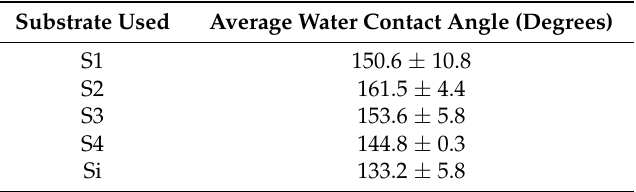
Table 2. Contact angle between a water droplet and the CNT forests grown on different